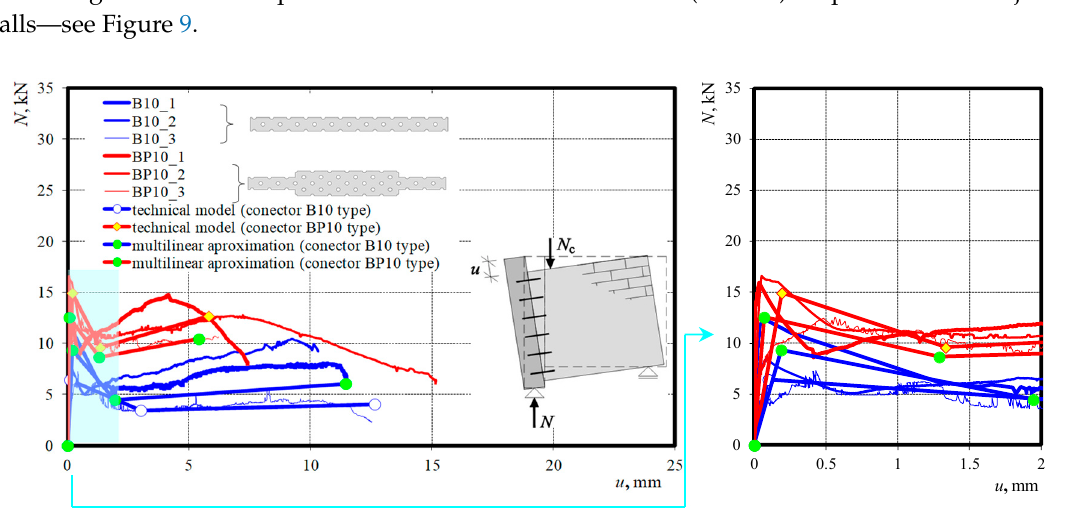
Figure 9. Relationship between the total force and mean displacement of joints.